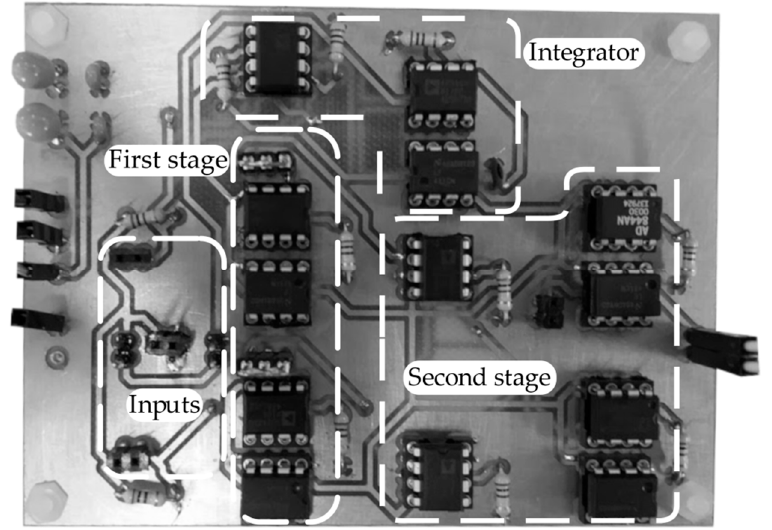
Figure 10. The prototyped interface.